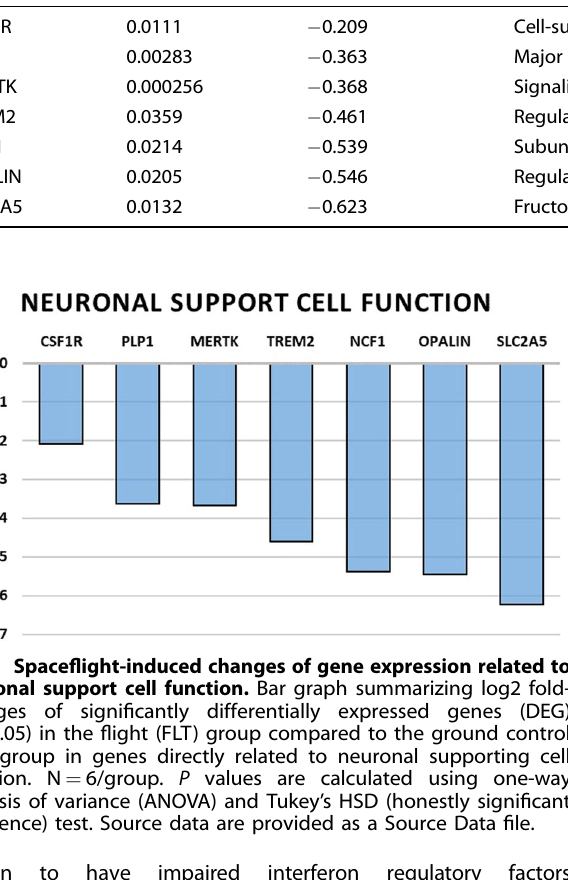
Table 3. Summary of signi fi cantly altered gene expressions by space fl ight related to neuronal support cell function. Gene p value